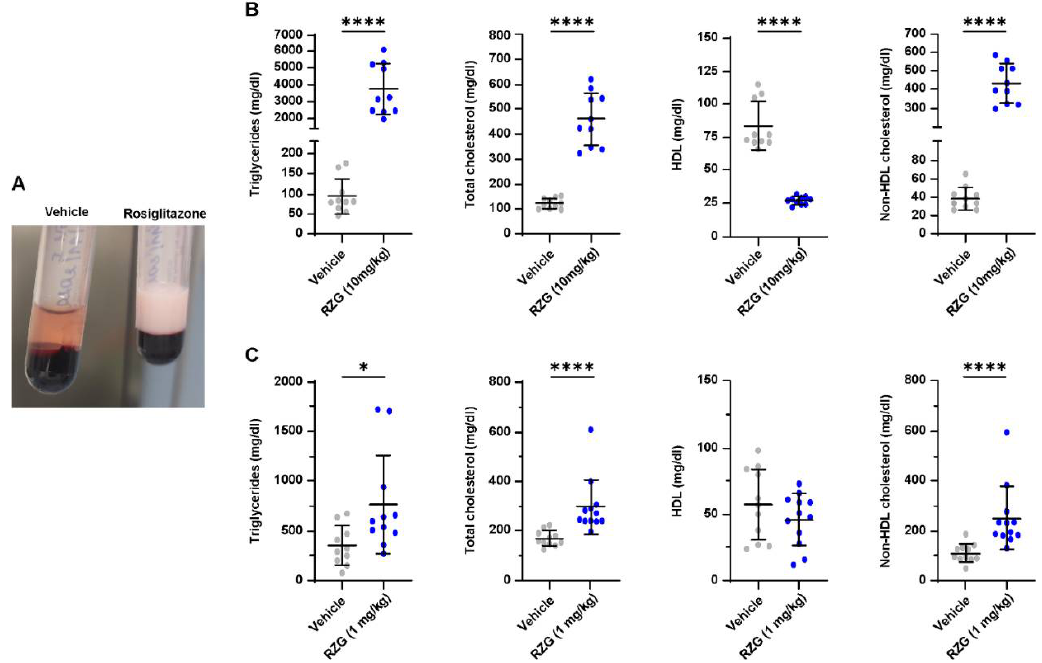
Figure 6. ( A ) A representative image of the macroscopic appearance of the plasma obtained from preterm rabbits exposed to hyperoxia (95% oxygen) for 7 days treated with daily rosiglitazone (RGZ, 10 mg/kg in the example), which shows a white, dense appearance compared with the plasma from another animal receiving the vehicle. ( B ) and ( C ), respectively, show the blood lipid levels in the groups of preterm rabbits exposed to hyperoxia either treated with daily doses of 1 and 10 mg/kg of rosiglitazone or the vehicle. Comparisons between groups were performed using the Mann– Whitney test except the comparisons between RZG 10 mg/kg and the vehicle for total cholesterol and non-HDL cholesterol, which were performed using an unpaired t-test. * p < 0.05; and **** p <